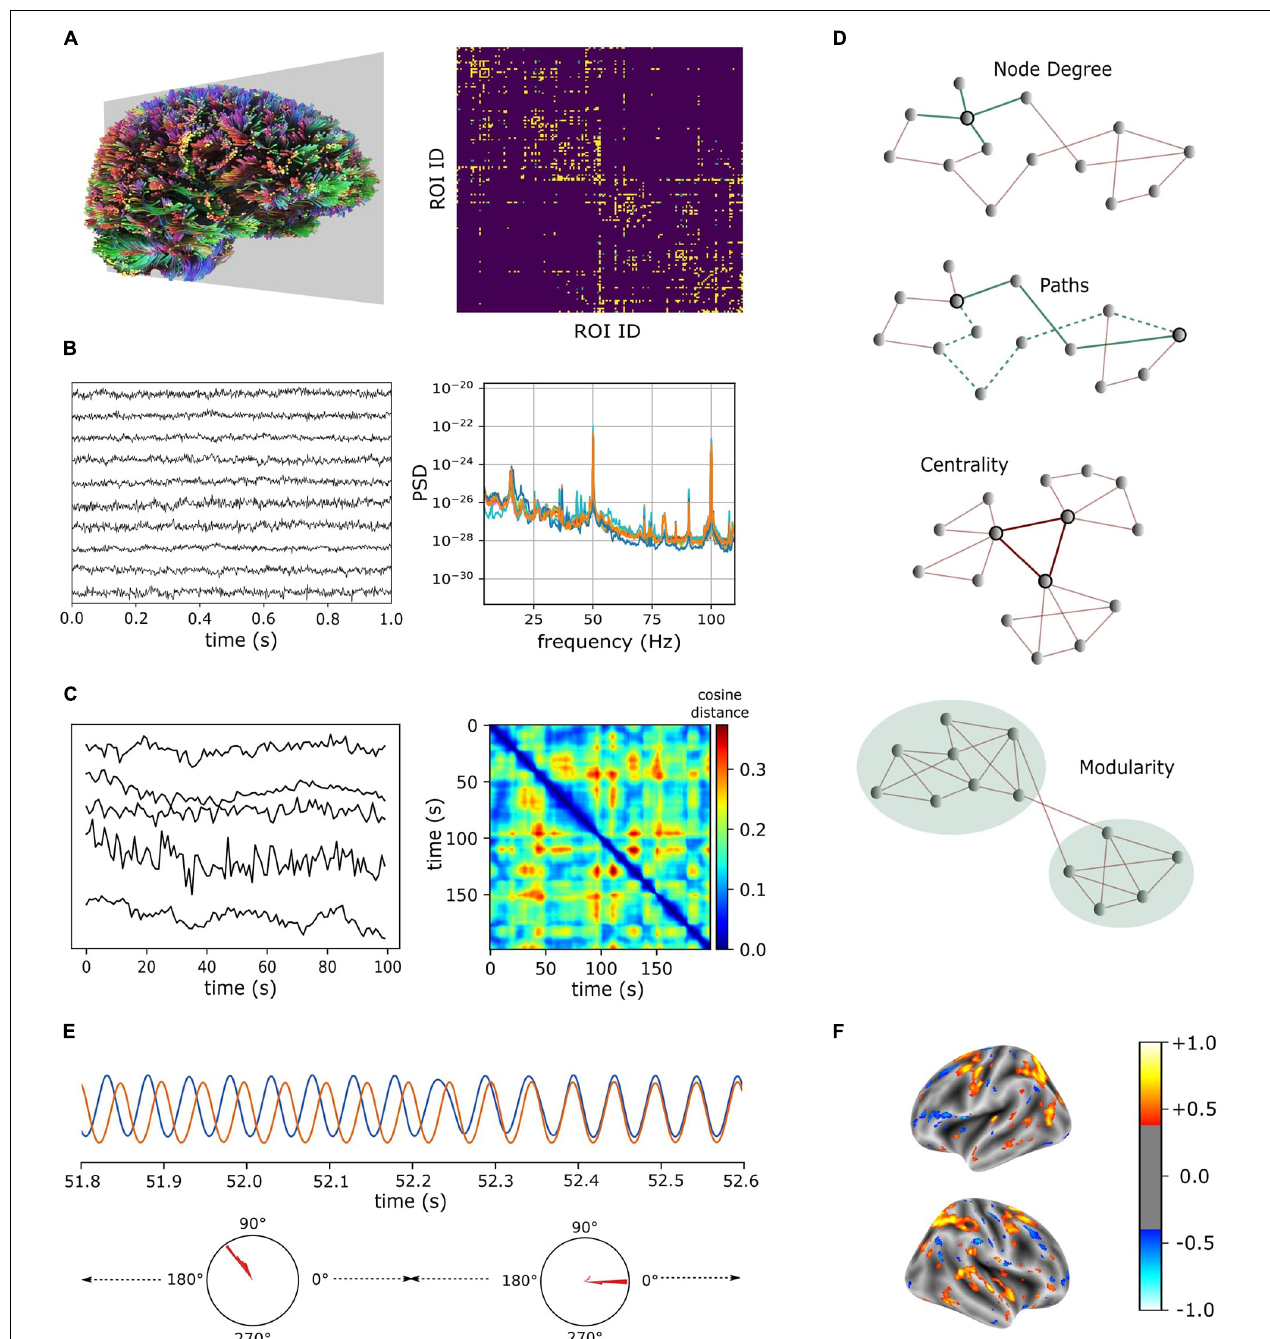
FIGURE 1 | Neuroimaging modalities (A–C) and characteristic features (D,E) for brain network structure and dynamics. (A) Fiber tracts estimated from dMRI (left) and connectivity matrix computed for brain regions that were parcellated according to Destrieux et al. (2010). (B) Recordings from MEG (10 representative channels, left) and their power spectral densities (right). (C) Sample BOLD signals measured from resting-state fMRI (left). Time-varying vectors of (resting-state fMRI) connectivity degrees showing intermittent similarities over time (right). dMRI and MEG data were obtained from CamCAN repository (Taylor et al., 2017) and fMRI data were obtained from the connectomeDB lifespan cohort (Van Essen et al., 2013). (D) Features of a graph (from top to bottom): Highlighted node has a degree of 4, two representative paths between the highlighted nodes are given in green (solid green denotes the shortest path), central nodes in a graph form a hub, and a graph is subdivided into two communities based on the intra- and inter-community connection densities. (E) Metastable attractors in a system of interacting oscillators. Phase difference (mode) between two oscillators is stable over several cycles and endogenously switches between different modes. (F) A schema illustrating the outcome of regression analysis that uses regional characteristic features to identify predictive markers of neurological disorders (color bar denotes model coefficients).